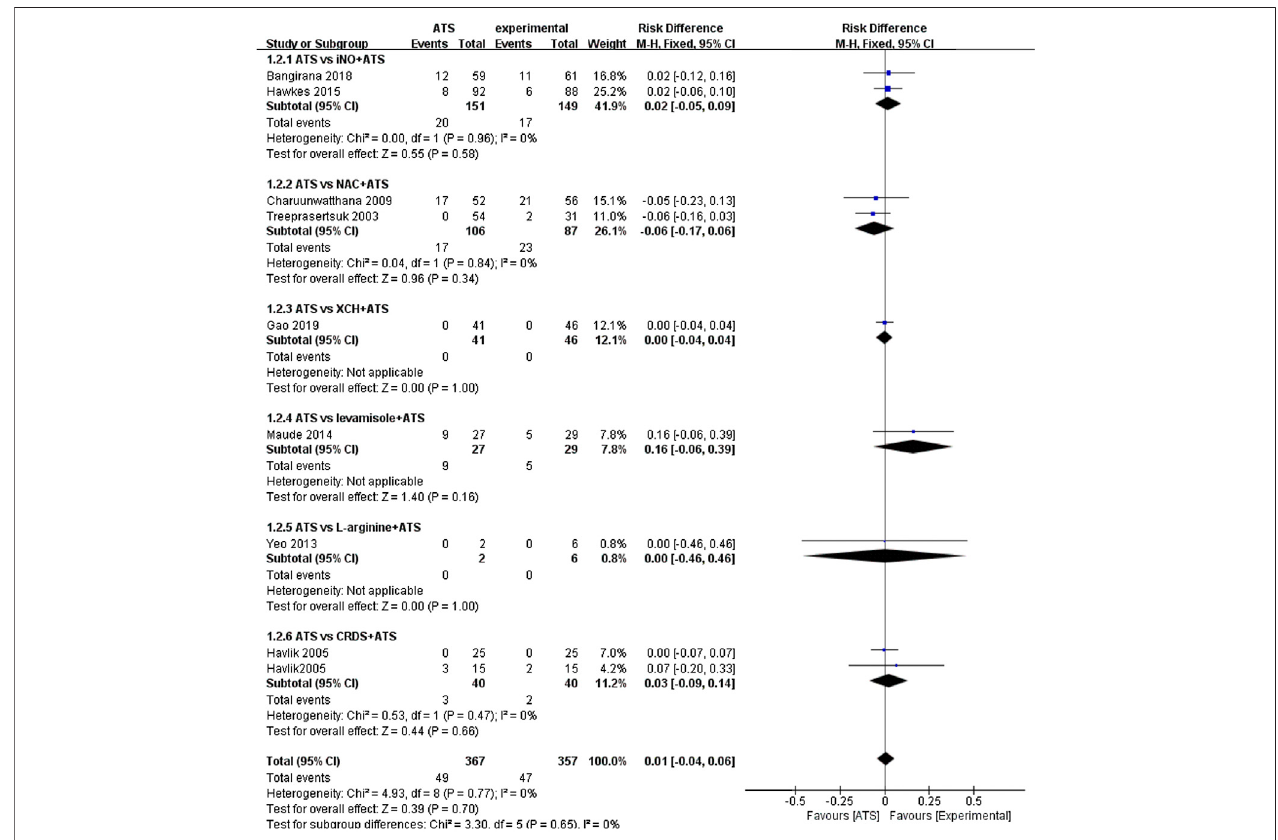
FIGURE 2 | Comparison of mortality rates in ATS monotherapy group and ATS + adjuvant therapy group.